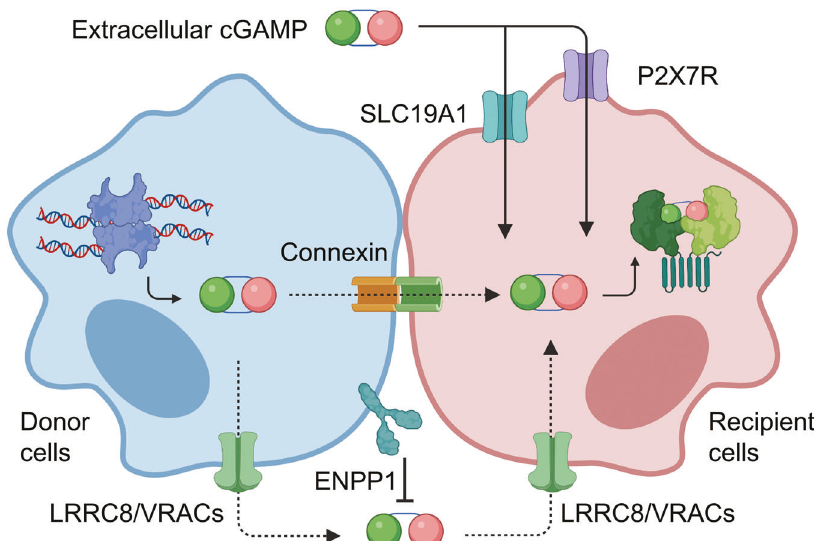
Fig. 2 cGAS activation by DNA binding. cGAS binds to dsDNA ≥ 18 bp and can form dimers when the DNA sequence is suf fi ciently long or is bent by other factors (e.g., TFAM). Liquid phase condensation leads to the stable ladder/net interaction of cGAS and enhances its catalytic